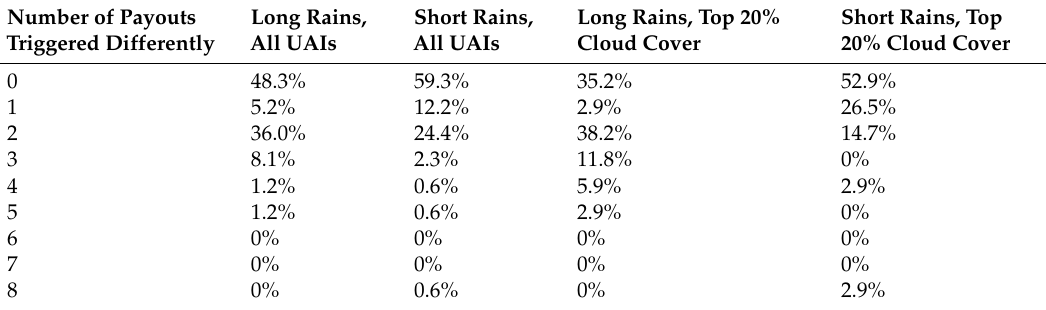
Table 2. Number of payouts triggered at different times for all UAIs.